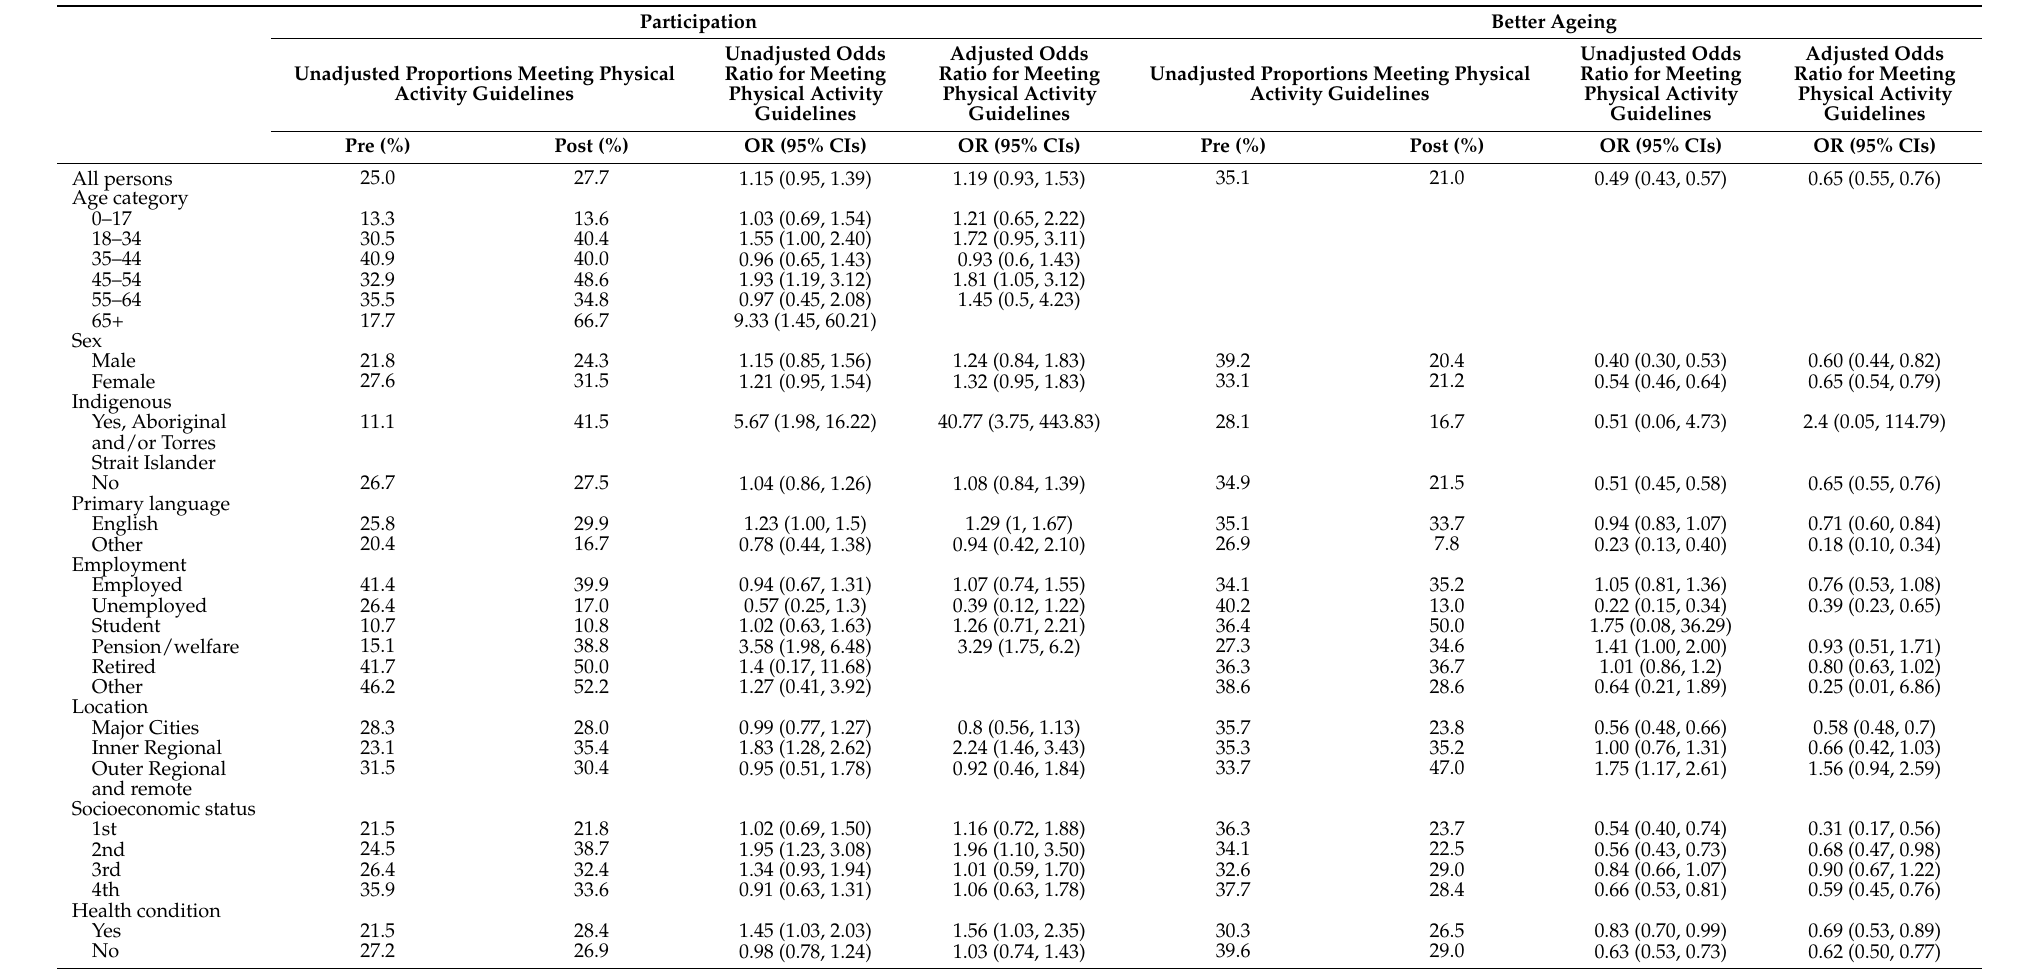
Table 3. Odds of meeting physical activity guidelines across timepoints in the Participation and Better ageing funding